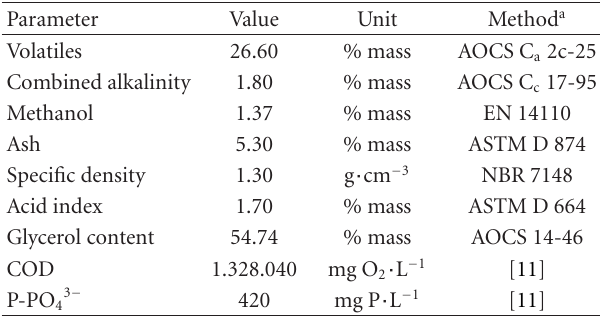
Table 1: Composition of the crude soybean biodiesel by-product (biodiesel glycerol).